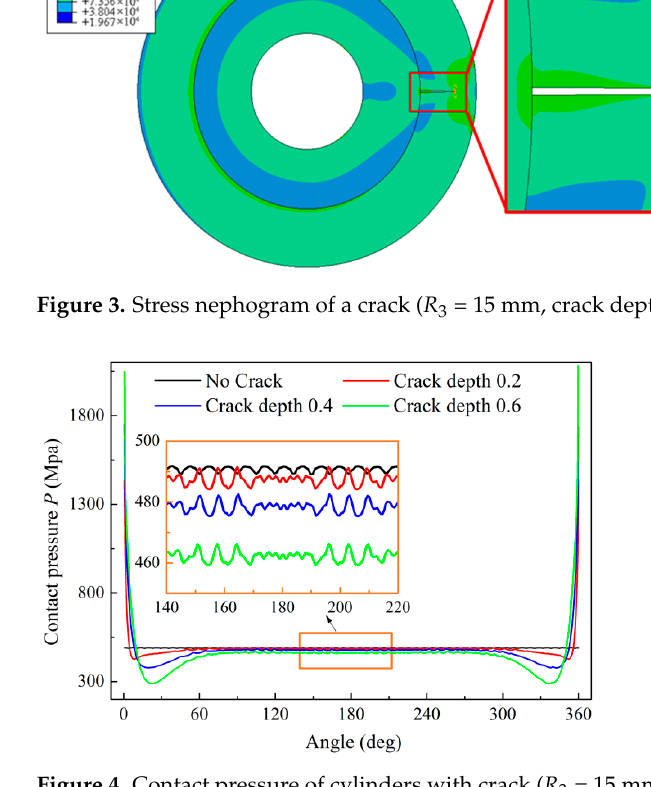
Figure 3. Stress nephogram of a crack ( R 3 = 15 mm, crack depth = 0.6).